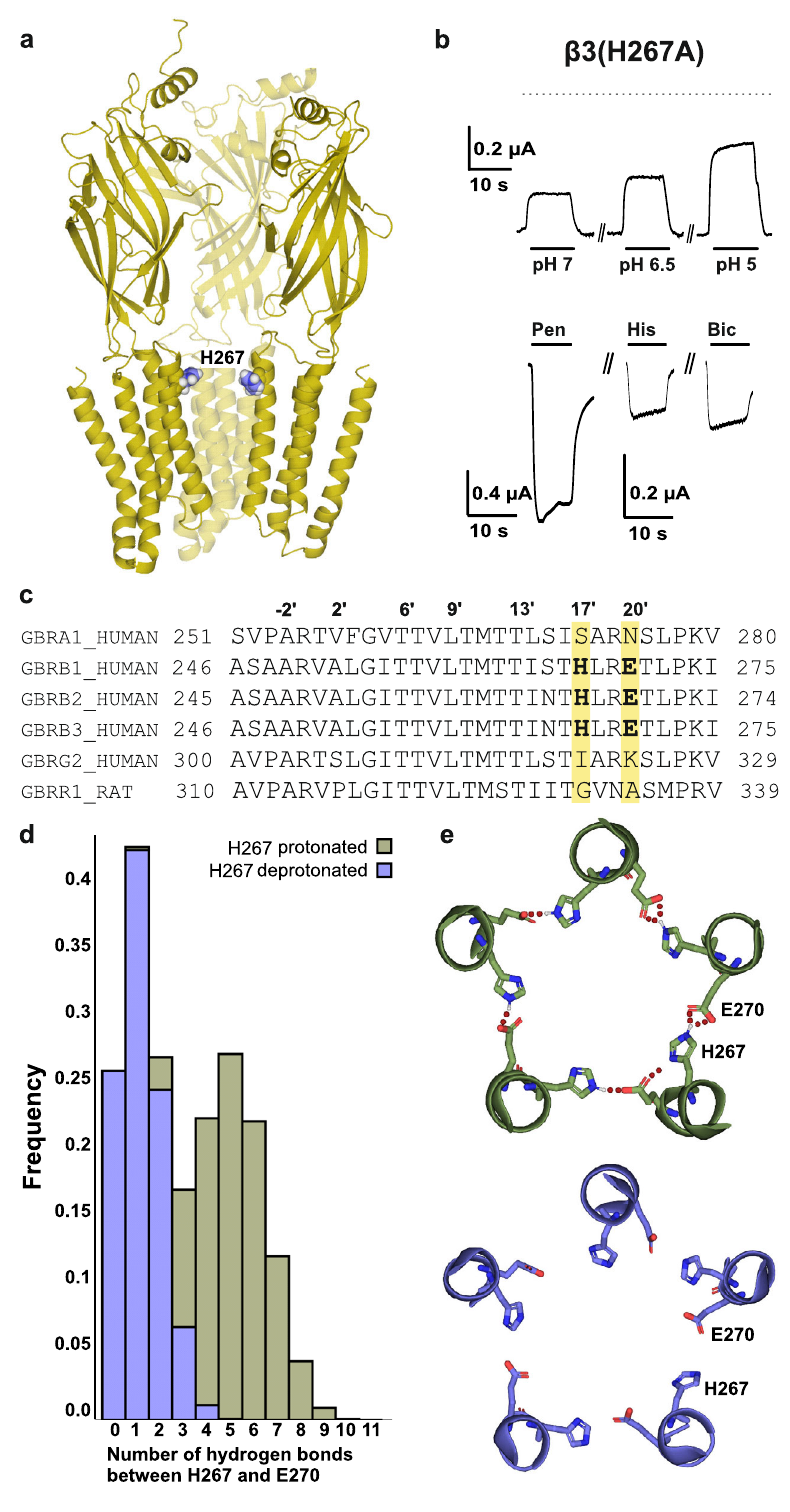
activation curve and its steeper slope result from mutation S265N or represent higher proton sensitivity of β 1 homomers (Fig. 1d). Acidi fi cations at physiological pH (e.g. pH changes from 7.2 to 6.5) activate I H( β x) which highlights the high proton sensitivity of these channels (illustrated for I H( β 3) in Fig. 2c, see also Supplementary Fig.